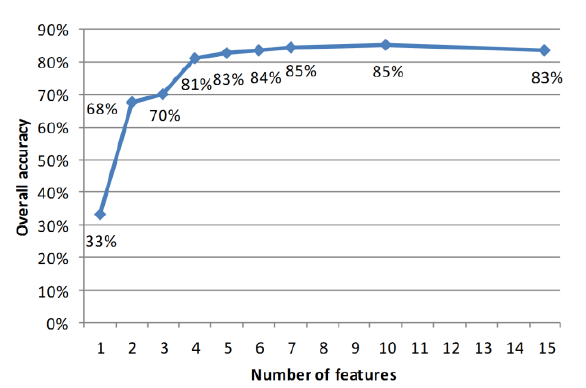
Figure 7. Classification results with increasing the numbers of wavelons